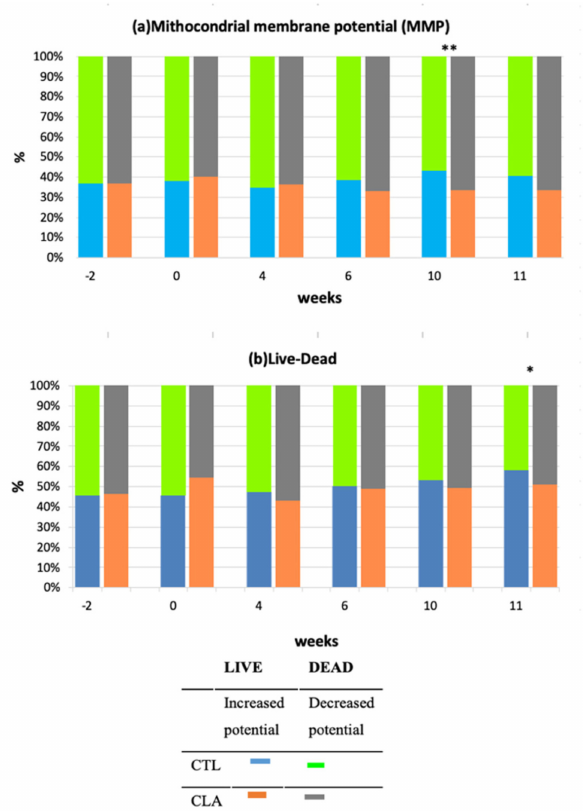
Figure 5. Effect of CLA supplementation on post-thawed bovine semen flow cytometer analysis of mitochondrial membrane potential ( a ) and live–dead sperm ( b ) for control (CTL) and CLA group (LSM ± SE). ** Significant levels p ≤ 0.05, and * a trend p ≤